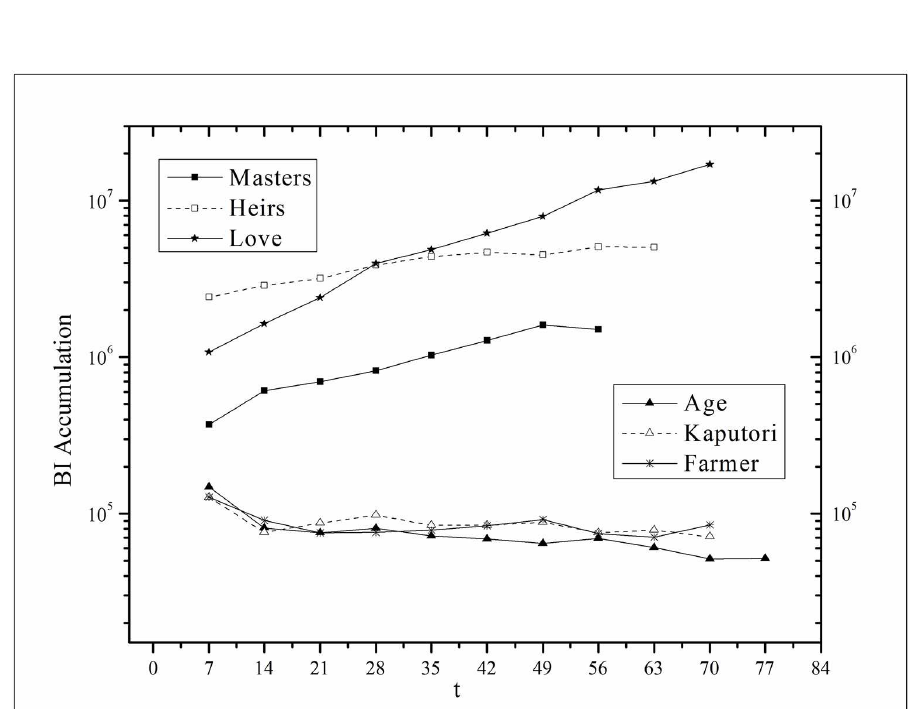
Fig 16. Comparison of BI accumulation of the six datasets.